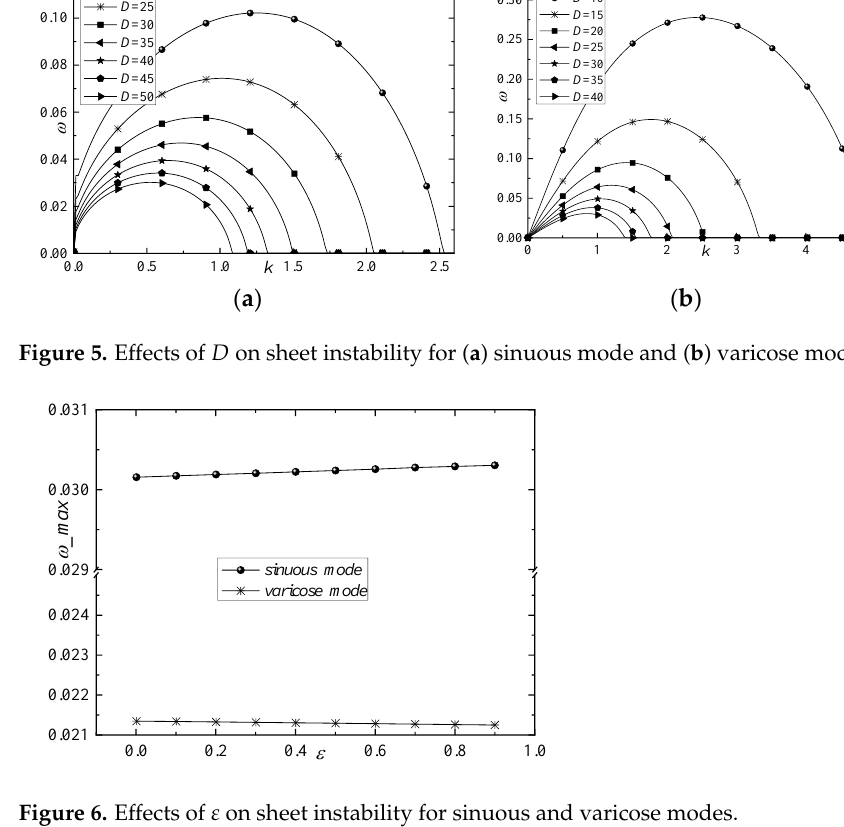
Figure 6. Effects of ε on sheet instability for sinuous and varicose modes.